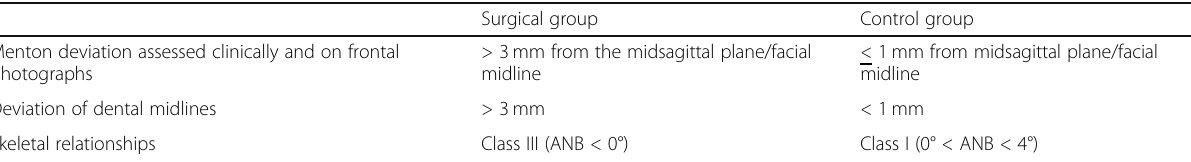
Surgical group Control group